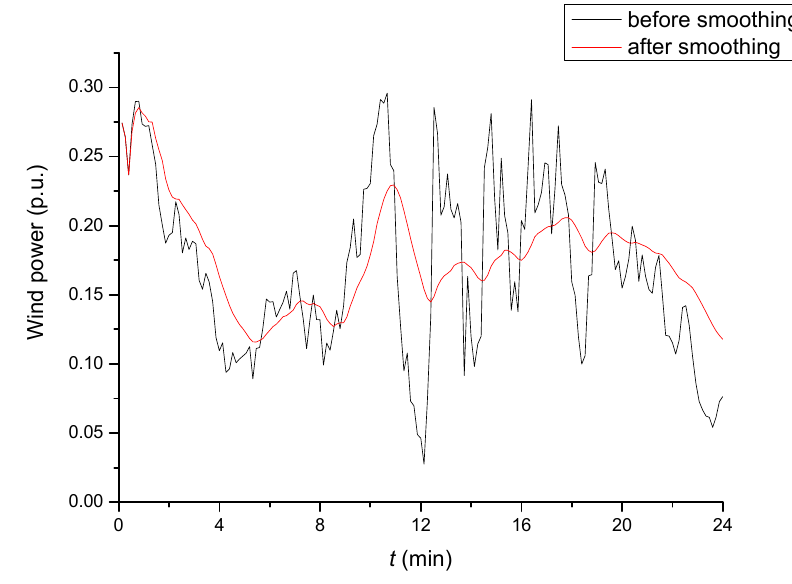
Figure 4. Wind power before and after smoothing.